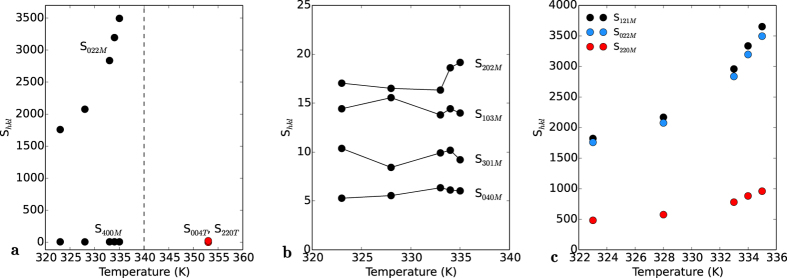
(a) Temperature-dependent comparison of strain broadening parameters extracted using the Stephens method. S022M and S400M correspond to the covariances of the B and C reciprocal axes and the variance of the A axis for the Monoclinic structure respectively and are plotted in black. S220T and S400T are the equivalent parameters for the Tetragonal structure, plotted in red. A clear divergence in the covariance of the Monoclinic B and C axes (S022M) is observed as the temperature approaches the critical point (~340 K, indicated by a dashed line). (b) Comparison of the Monoclinic Stephens strain parameters with no component along the Monoclinic b-axis and (c) Comparison of the S121M, S022M and S202M parameters, illustrating that while there is some correlation between broadening involcing the a- and c-axes, it is far smaller than the broadening involving both the b- and c-axes.